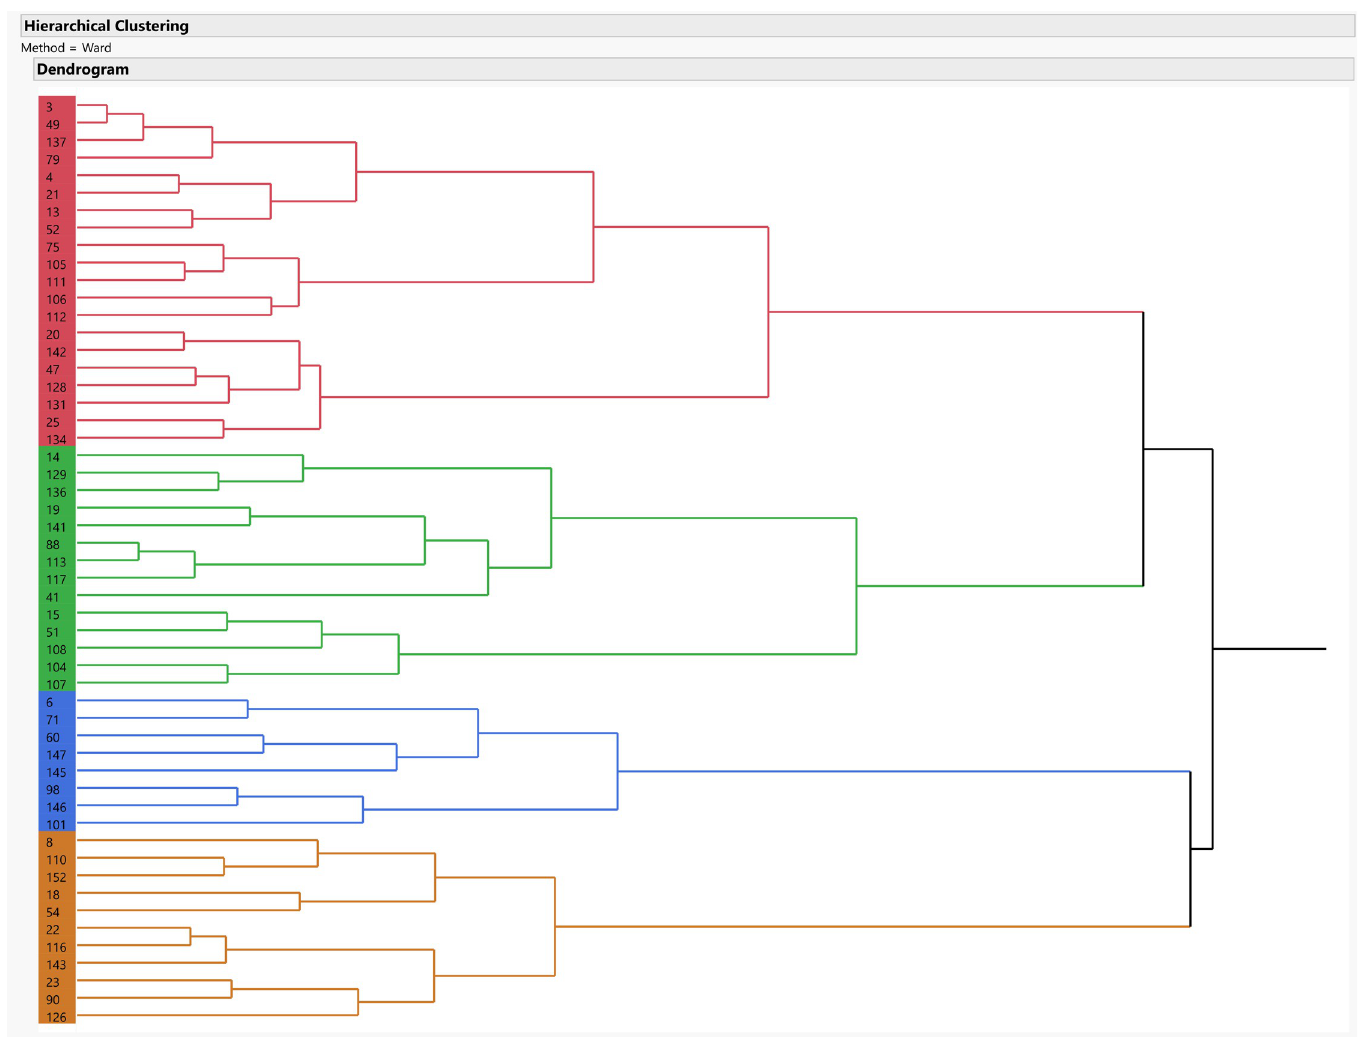
Fig 37. Dendrogram reflecting the hierarchical clustering based on morphological distances between specimens. Colors reflect the four clusters cut-off; labels are artifact numbers.